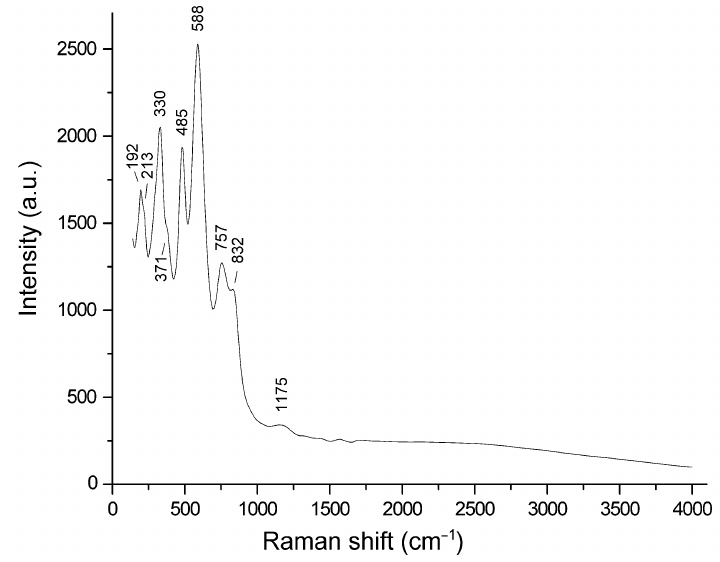
Figure 3. Raman spectrum of laachite Ca 2 Zr 2 Nb 2 TiFeO 14 obtained with the polarization of the laser beam parallel to the a axis of the crystal